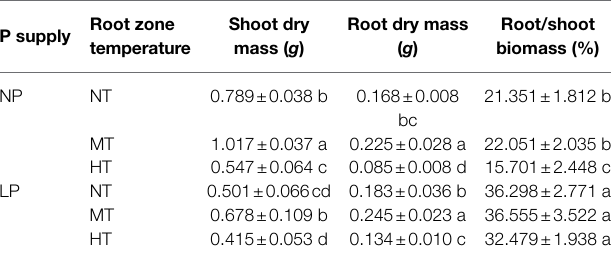
TABLE 2 | Effect of root zone temperature and phosphorus content on the biomass accumulation and allocation in maize.